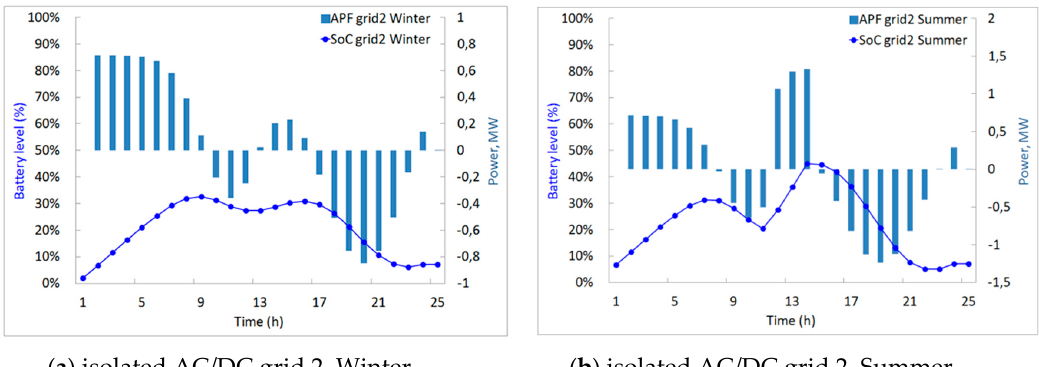
Figure 9. Alternating power functions (APF in MW) with state of charge information (SoC in %) for second grid in community of grids computed by System of Volterra integral equations (VIE) for winter and summer period.